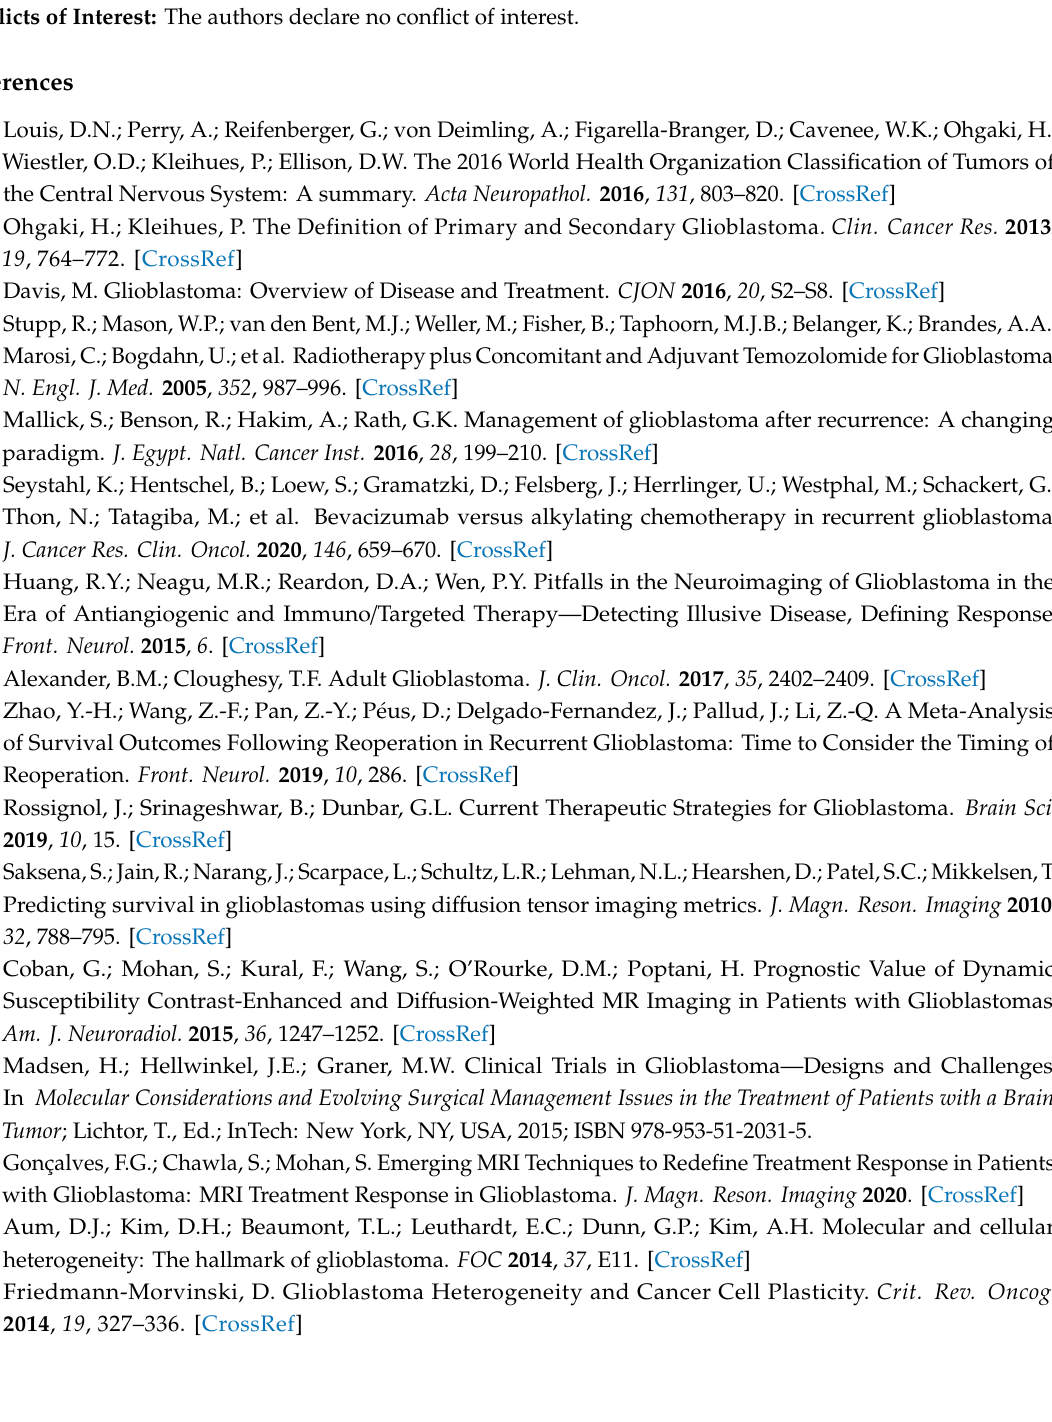
Table S1: Key terms used in literature search, Table S2: PRISMA Checklist, Table S3: Quality assessment using QUIPS